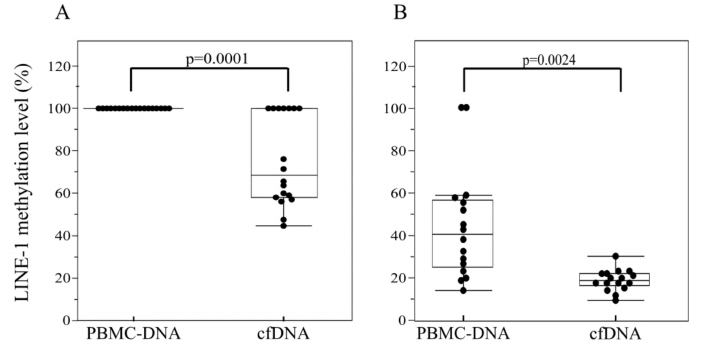
Figure 5. Dot plot of LINE-1 methylation level. Status of external cytosine of site A ( A ) and of site B ( B ) in PBMC and